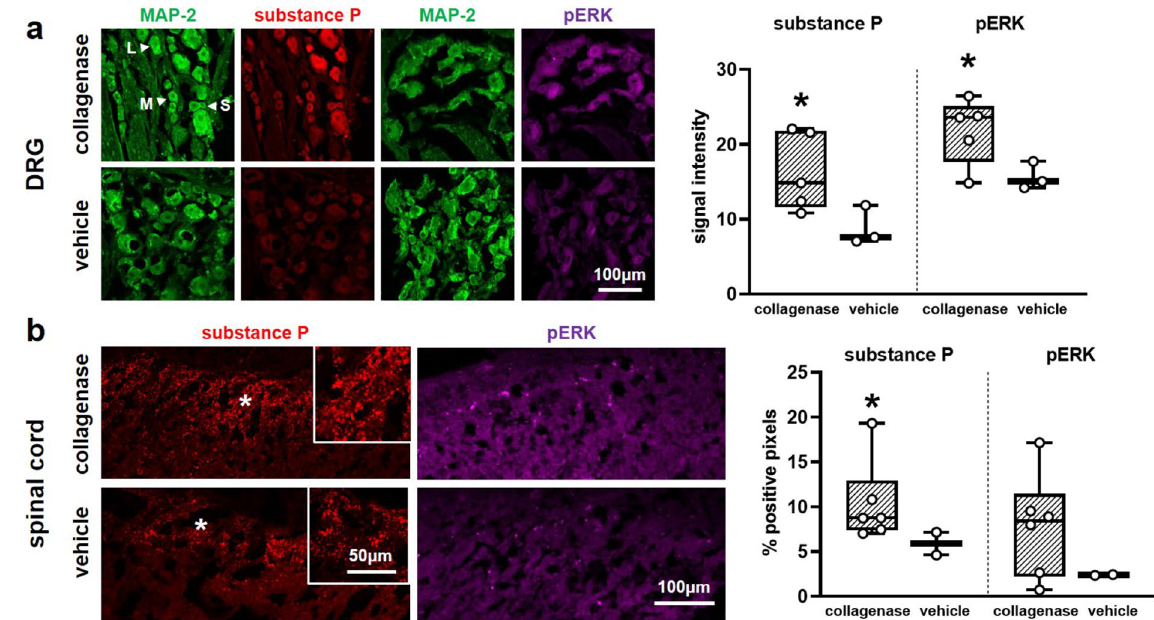
Figure 4. Immunolabeling of substance P and phosphorylated ERK in the dorsal root ganglia (DRG) and spinal cord at day 21. ( a ) Quantification of labeling intensity for the neurotransmitter substance P (red) and the MAP kinase pERK (purple) in cells with MAP-2 (green) positive labeling shows elevated expression after collagenase (5 rats) injection relative to vehicle (3 rats) injection for both substance P (Wilcoxon test; *p < 0.001) and pERK (Wilcoxon test; *p < 0.001) regardless of neuronal size (see Supplementary Fig. S1 online). White arrows indicate exemplary neurons identified as small (S), medium (M), or large (L) diameter neurons. Data points superimposed on box plots in ( a ) represent the mean for each rat (n = 5–7 images/rat; n = 10 cells/image). ( b ) Intra-articular collagenase (6 rats) also induces increased positive labeling for substance P (red) and pERK (purple) in the superficial dorsal horn. Spinal substance P (Wilcoxon test; *p = 0.039) is significantly greater after collagenase injection than after injection of the vehicle (2 rats), but the same increase is not detected with pERK expression (Wilcoxon test; p = 0.147). Spinal cord images show regions of the superficial dorsal horn (700 × 300 pixels) where immunolabels were quantified; insets show higher magnification of regions (white stars) to demonstrate positive substance P labeling. Individual data points on boxplots in ( b ) represent the mean value per rat quantified for 6–8 images/rat. For both panels, box-and-whisker plots show horizontal lines representing the first (lower) quartile, median, and third (upper) quartile of the data and whiskers represent the minimum and maximum values of the data